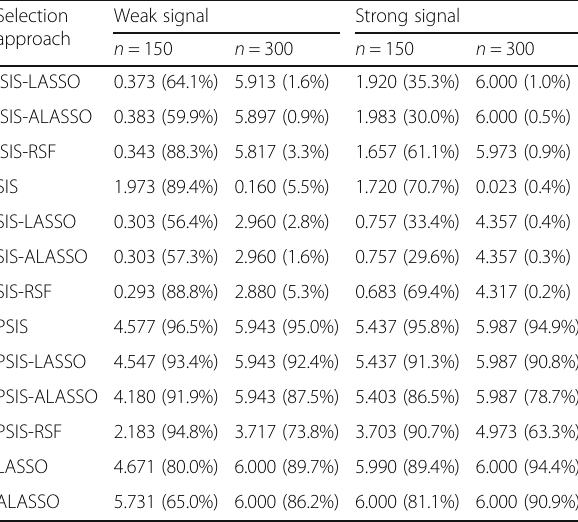
Table 3 Mean of the number of informative features (% of uninformative features) selected in final model over 300 simulations in the training